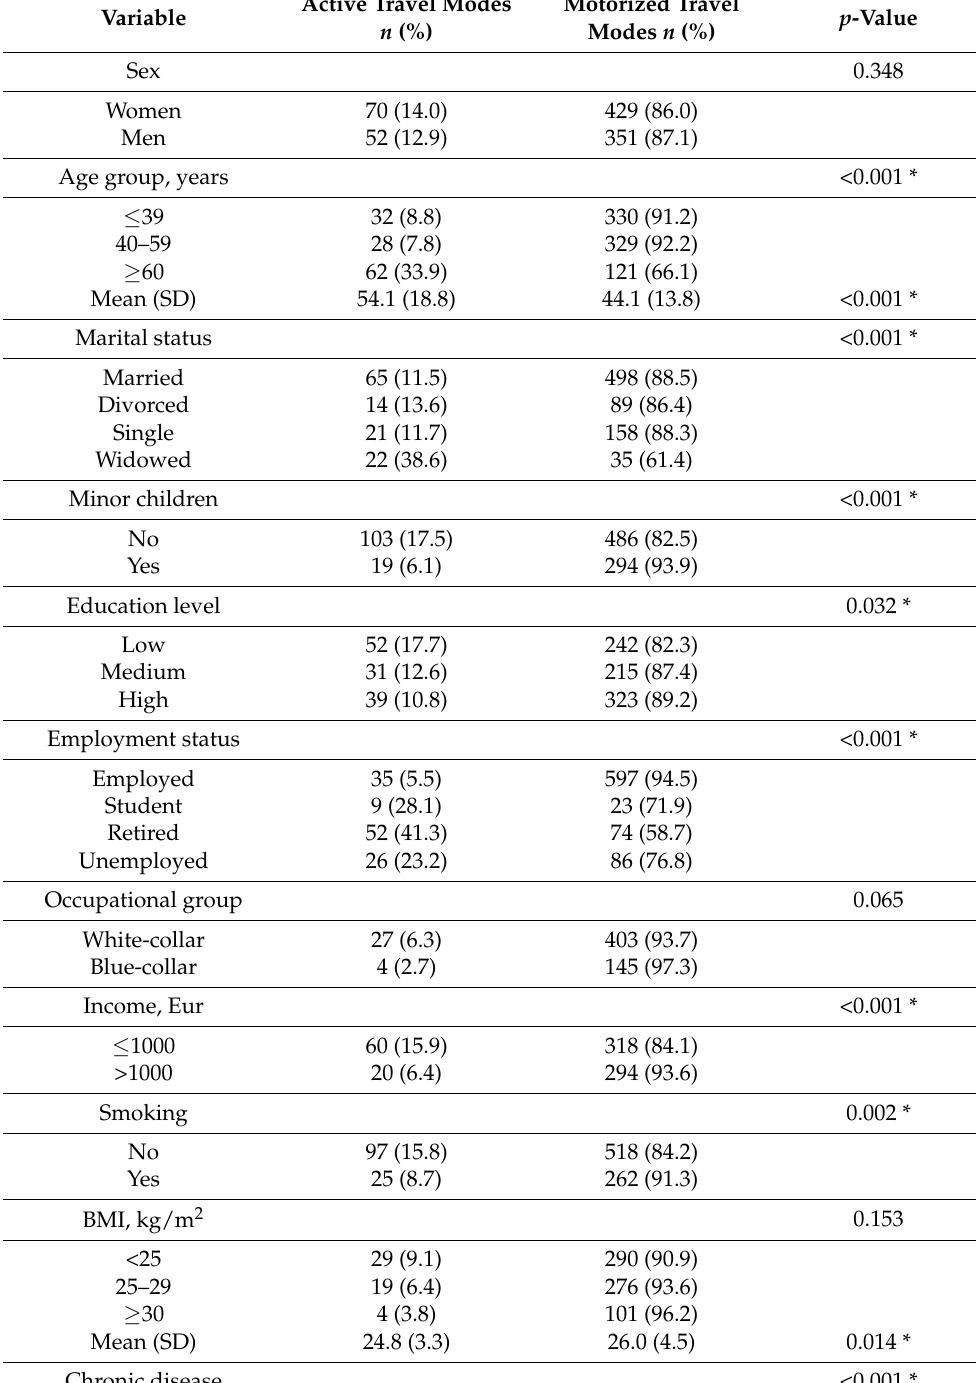
Table 2. Individual characteristics of the study participants by active and motorized travel modes ( n =